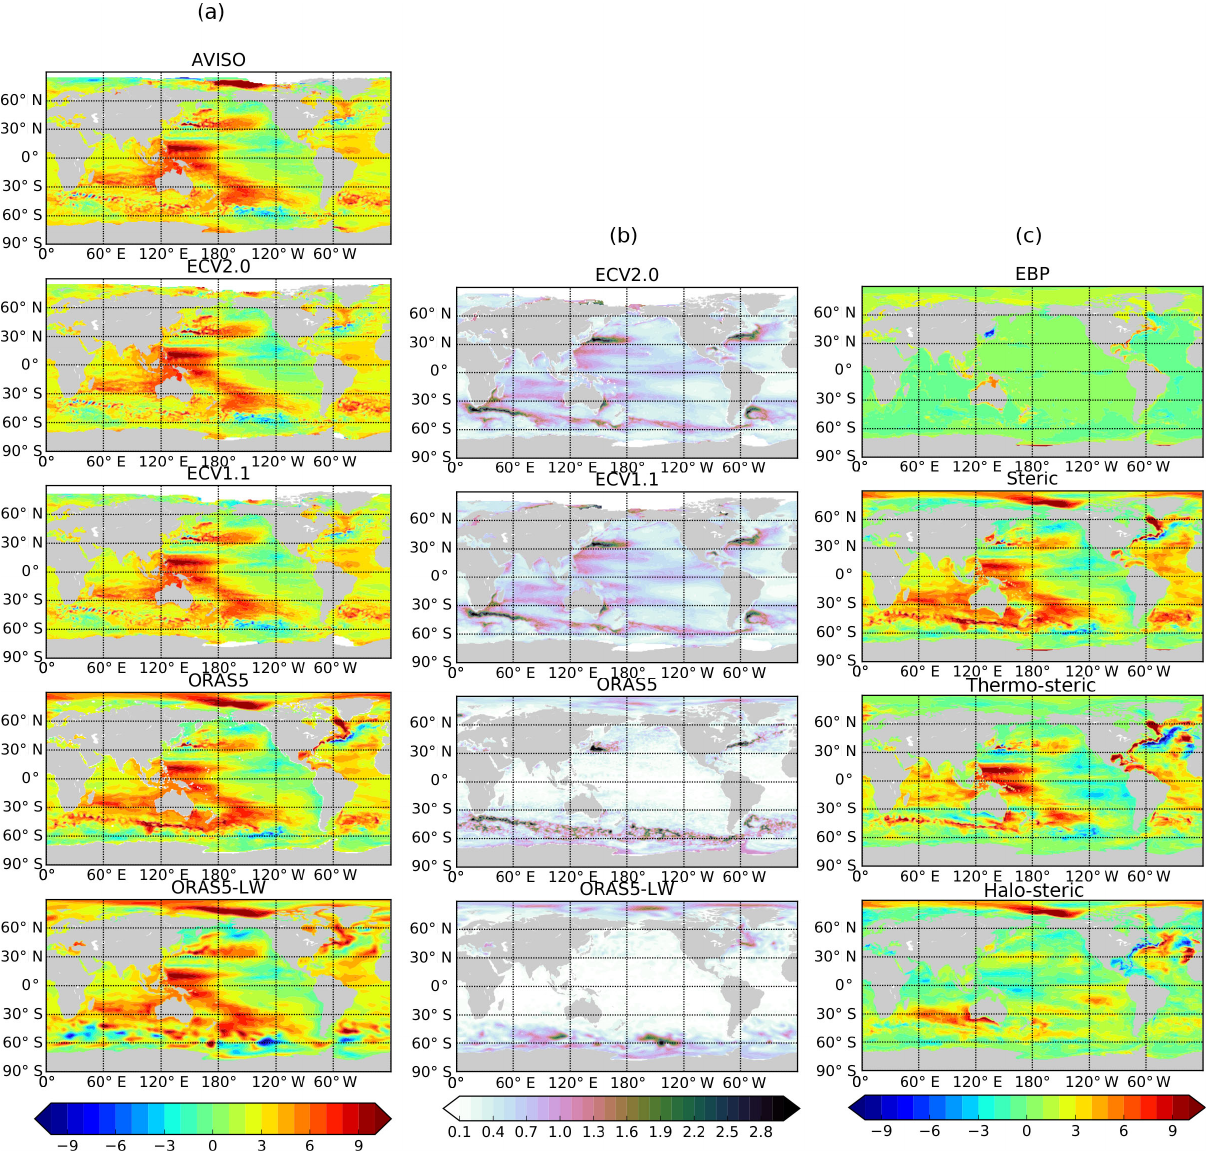
Figure 11. (a) Mean sea level trends (in mmyr − 1 ) and (b) uncertainties in DUACS DT2014, SL_cci ECV v2.0 and v1.1, ORAS5, and ORAS5-LW. MSL trends are computed using monthly mean sea level data from 1993–2014. Trend uncertainties have been provided as climate indicators with the ECV products and were estimated using ensemble spread from five ensemble members of ECMWF ORAs; (c) attributions of the MSL trends derived from ORAS5 as, from top to bottom, equivalent bottom pressure (EBP) mass variations, steric changes, and thermo-steric and halo-steric changes for the same